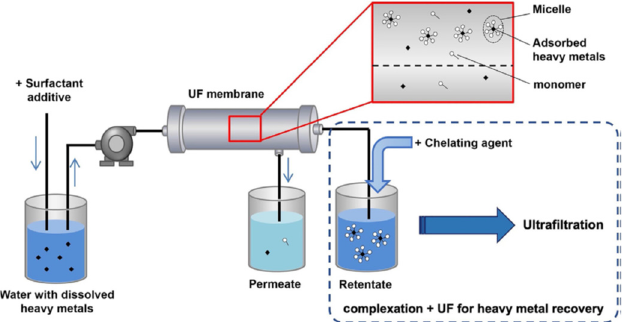
Figure 8. Schematic illustration of MEUF for heavy metal recovery [45]. Reproduced with permission from Wenten, I.G.; Khoiruddin, K.; Wardani, A.K.; Widiasa, I.N., Synthetic Polymeric Membranes for Advanced Water Treatment, Gas Separation, and Energy Sustainability; published by Elsevier, 2020.